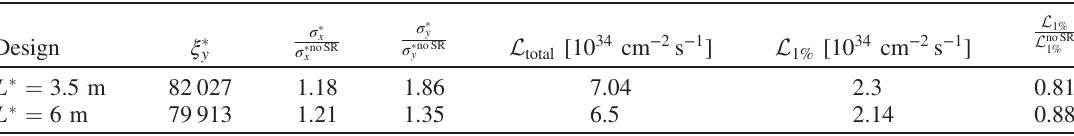
TABLE III. Simulated performance of both L (cid:1) options when the beam is tracked through the entire BDS (for L (cid:1) ¼ 6 m, β (cid:1) ¼ 0 . 12 mm). Comparison of the vertical chromaticity, total and peak luminosities, and impact of y synchrotron radiation at the